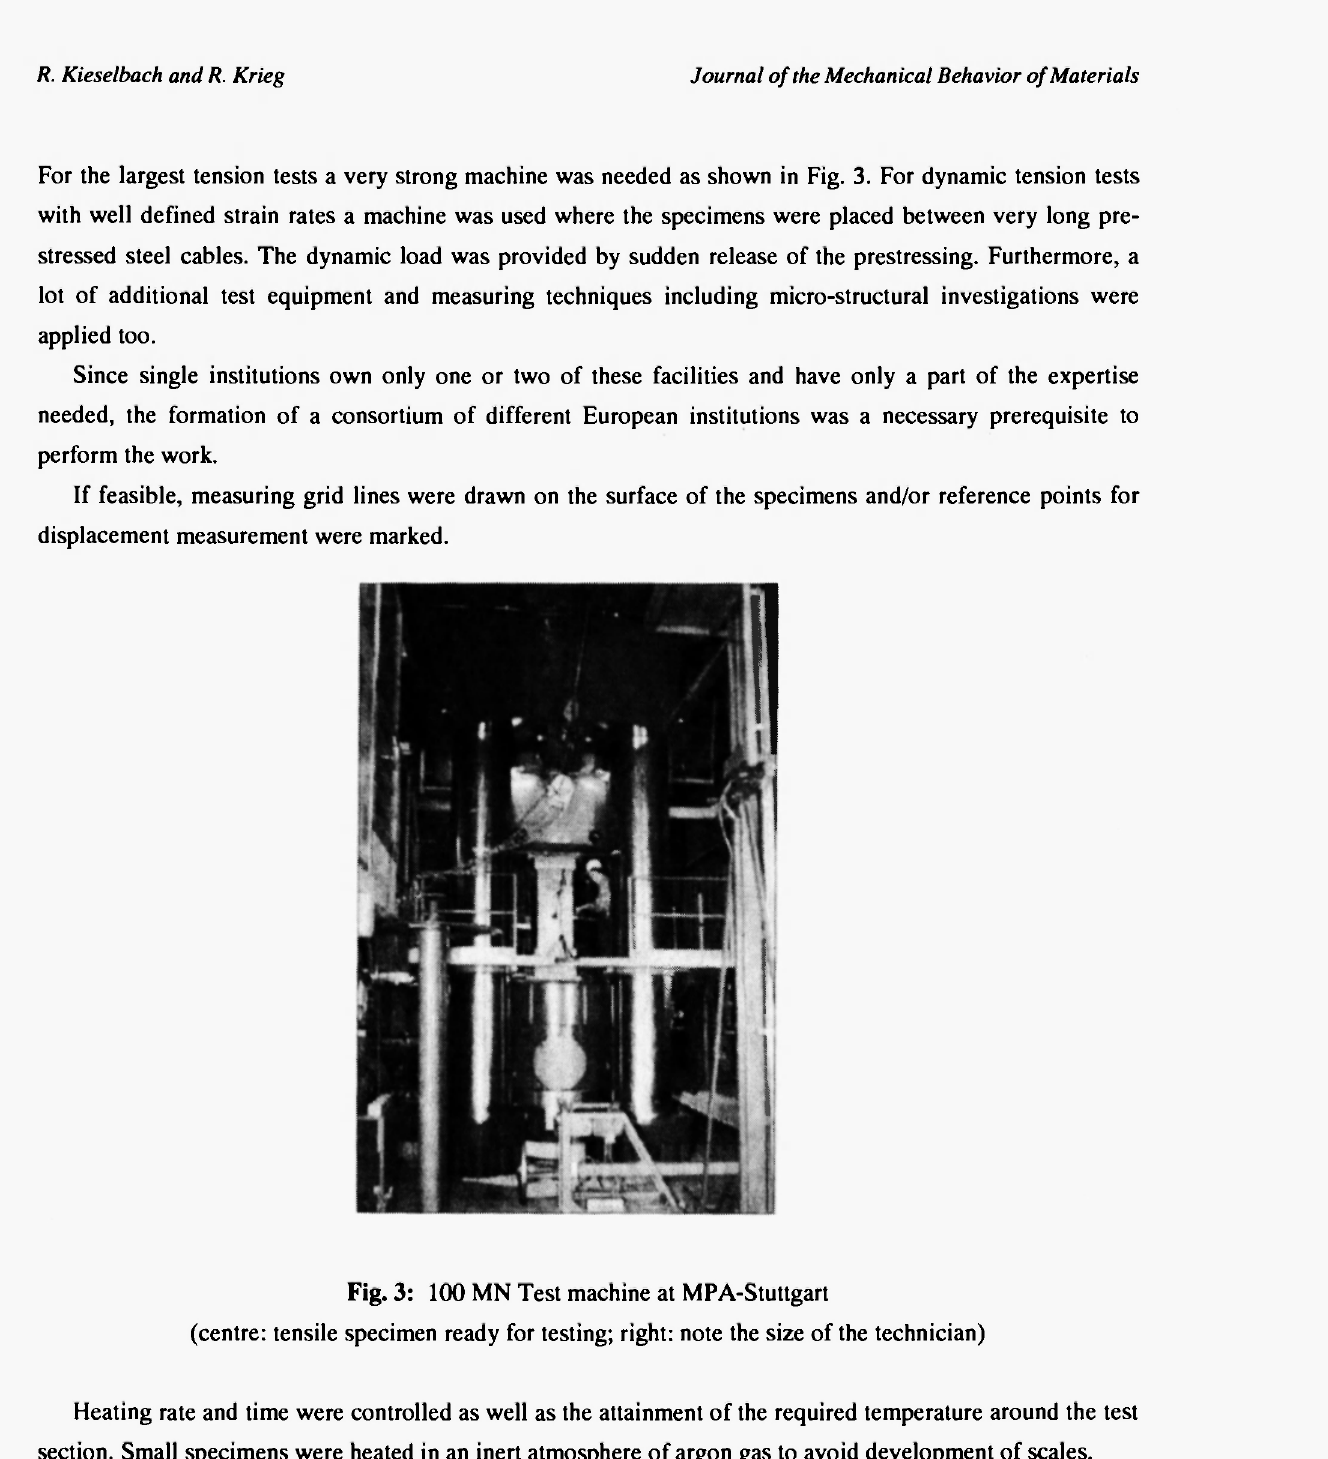
Fig. 3: 100 MN Test machine at